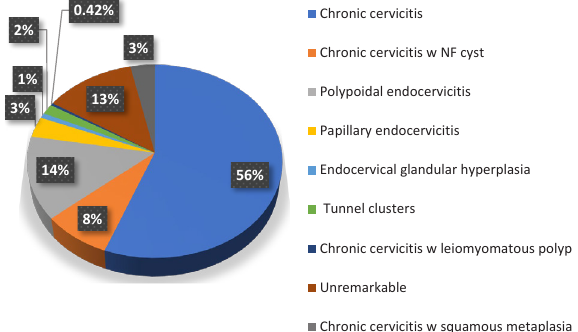
Figure 3. Histopathological Findings of the Cervix. Note. NF: Neurofibromatosis.